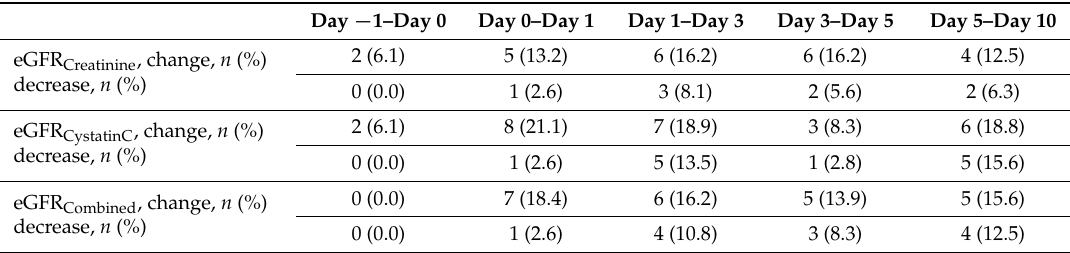
Table 5. Patients who are re-classified (change or decrease) at least one category. Change refers to both patients who are re-classified into a higher or lower category, whereas decrease refers to patients who are re-classified into a lower